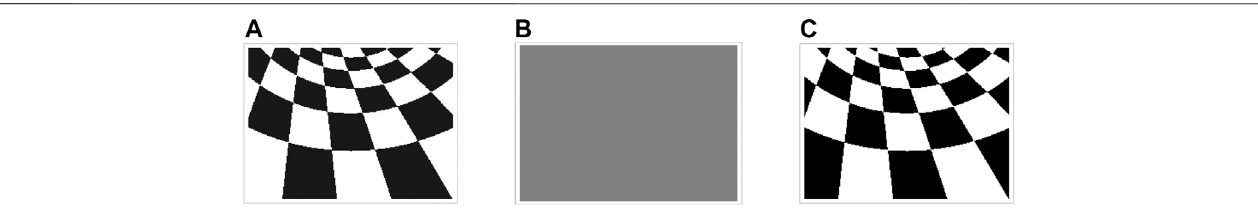
FIGURE 21 | (A) Black-and-white checkerboard visualizing the binary data stored in the locally distributed memristive memory bank previous to their retrieval. A white (black) pixel at row i and column j in this image reveals the on (off) resistance of the memristor in the M-CNN cell C ( i , j ) ( i ∈ { 1 , ... , M } , j ∈ { 1 , ... , N } , M (cid:1) 177 N (cid:1) 240). (B) Grey-scale image indicating the common − 0 . 15V-valued initial condition on each capacitor voltage. (C) Output binary image coding the steady-state output voltages of all the RECALL M-CNN processing elements. A black (white) pixel in correspondence to the i th row and j th column of this image denotes a positive (negative) saturation level +(−) v sat for the steady-state output voltage of the cell located in the corresponding position of the memristive cellular